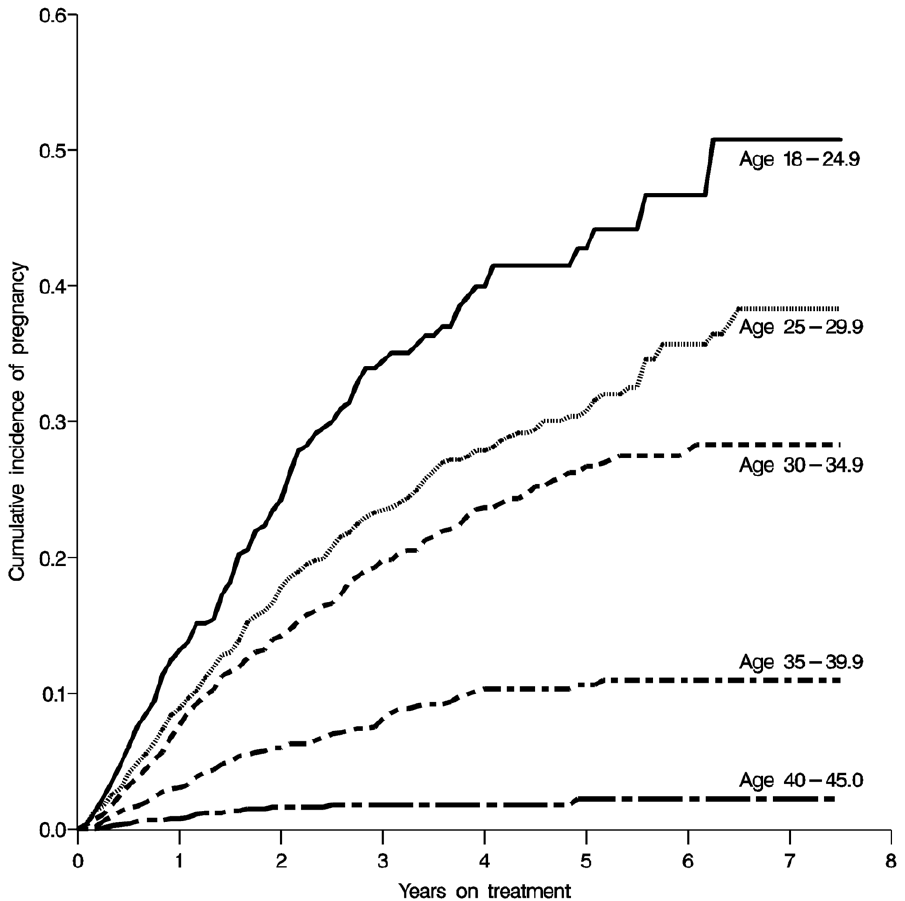
Figure 1. Cumulative risk of first incident pregnancy since HAART initiation, stratified by baseline age.